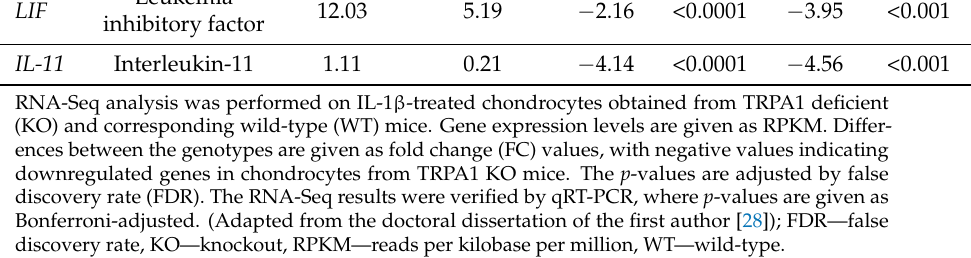
RNA-Seq analysis was performed on IL-1 β -treated chondrocytes obtained from TRPA1 deficient (KO) and corresponding wild-type (WT) mice. Gene expression levels are given as RPKM. Differ- ences between the genotypes are given as fold change (FC) values, with negative values indicating downregulated genes in chondrocytes from TRPA1 KO mice. The p -values are adjusted by false discovery rate (FDR). The RNA-Seq results were verified by qRT-PCR, where p -values are given as Bonferroni-adjusted. (Adapted from the doctoral dissertation of the first author [28]);